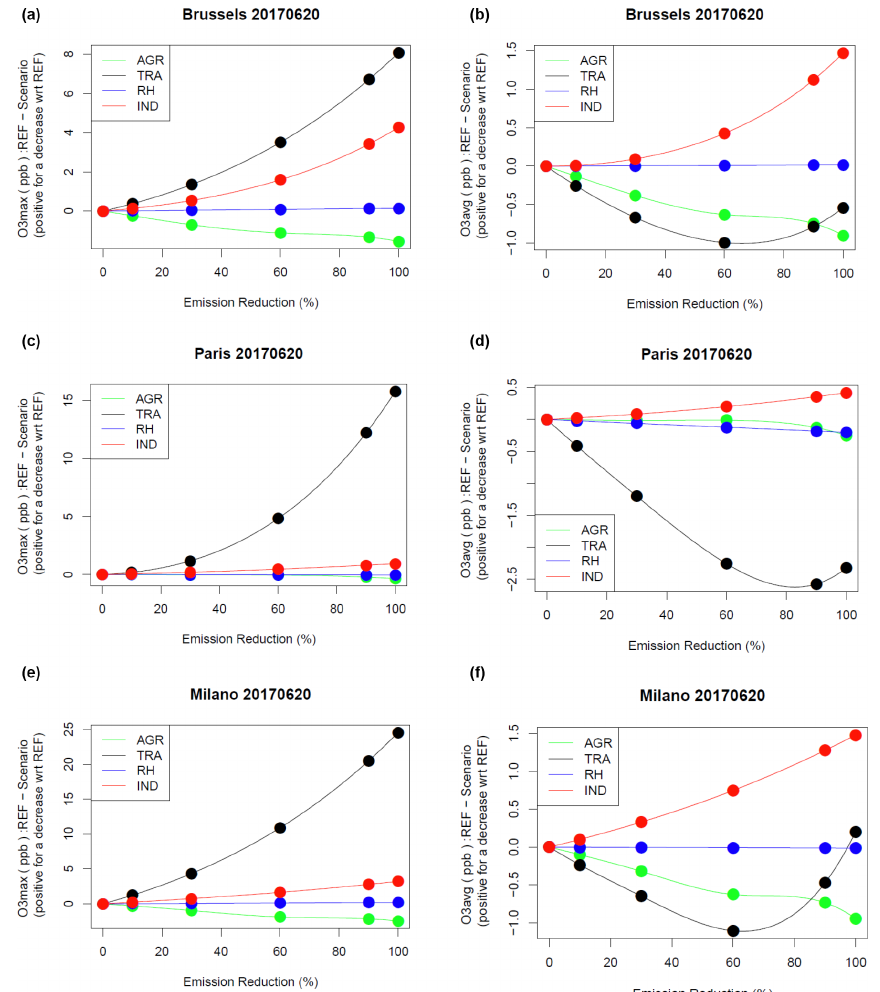
Figure 2. Same as Fig. 1 for ozone daily maximum (O 3 both sectors. In the CHIMERE modelling setup used